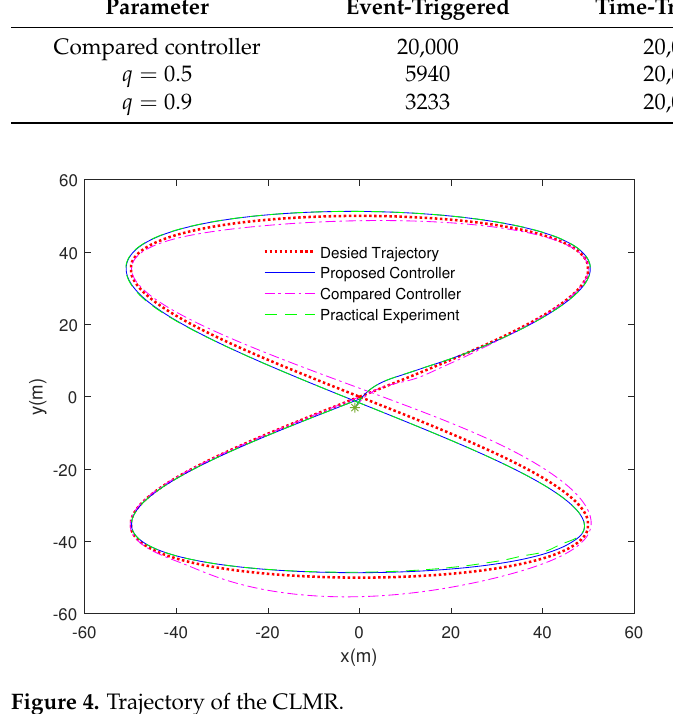
Figure 4. Trajectory of the CLMR.